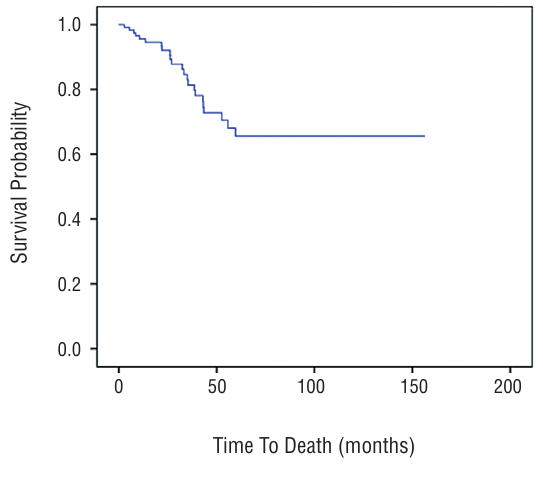
Figure 1 - Kaplan-Meier Cancer Specific Survival